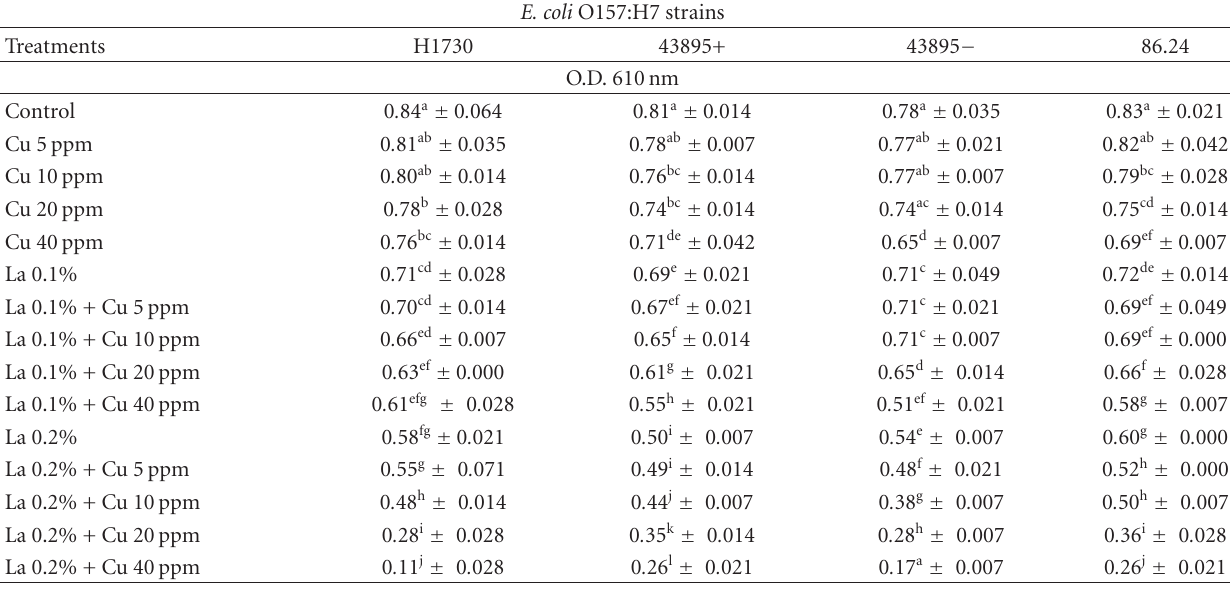
Table 1: Growth of E. coli O157:H7 strains in BHI broth (O.D.) after incubation for 8h at 37 ◦ C in the presence of (Cu) and lactic acid